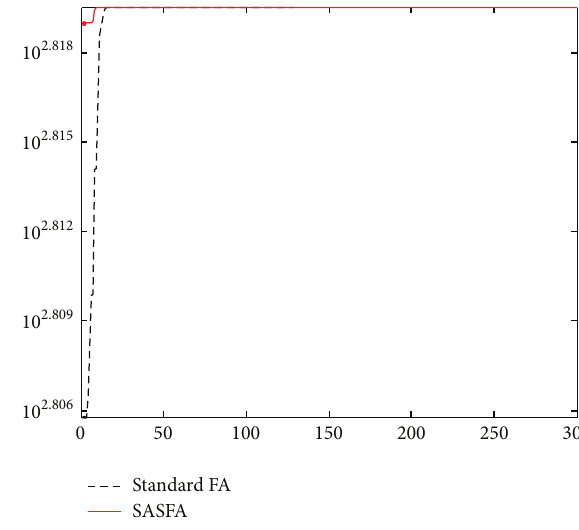
Figure 13: Comparison of curve graph for 𝑓 13 .